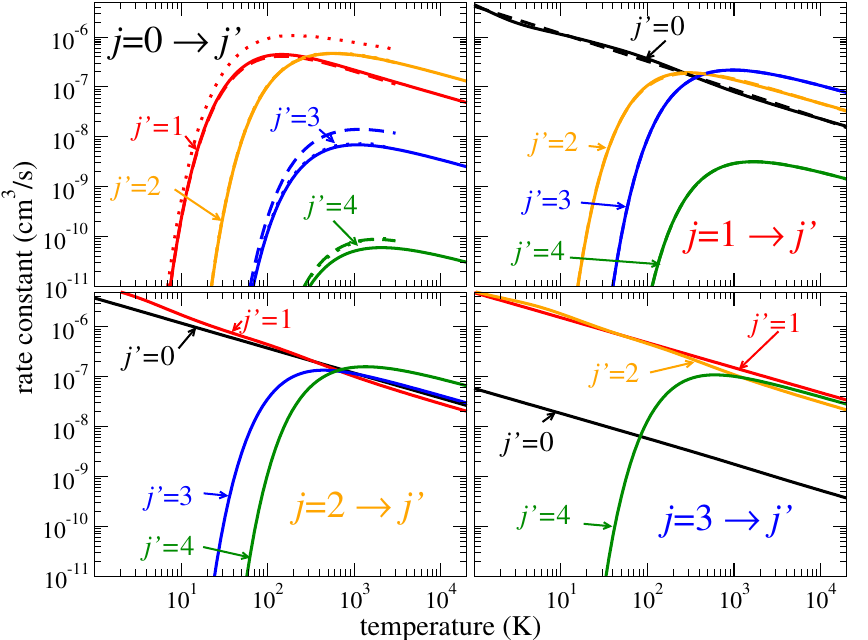
Figure 3. Rate coefficients (solid lines) for transitions from the four lowest rotational states of HeH + , j = 0, · · · ,3 rotational states. Dotted lines in the upper left panel are the calculations by Hamilton et al. [10], and the dashed lines are those of ˇCurík and Greene [17]. For the 0 → 1 transition, the dashed and solid lines overlap. For the 0 → 2 transition, the curves for all three calculations overlap. For the 0 → 3 transitions, the dotted and solid lines overlap. For the 0 → 4 transitions, the dotted and dashed lines